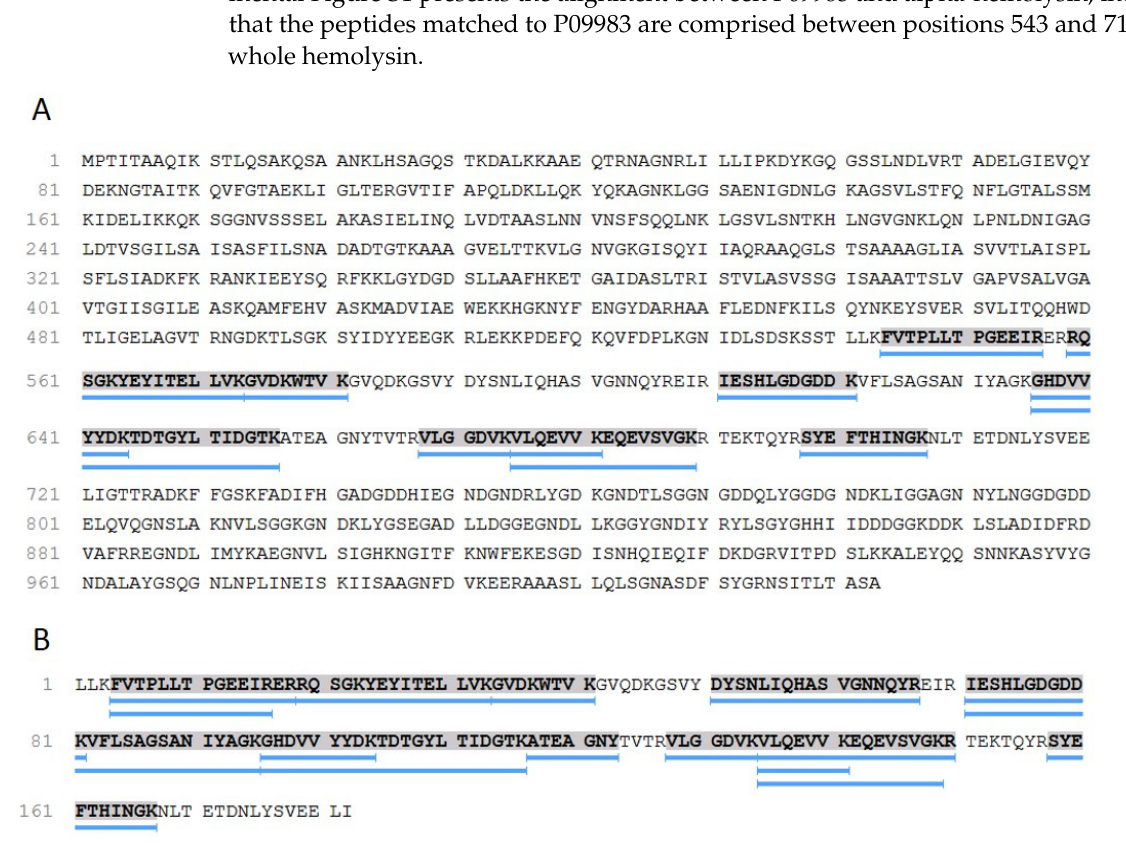
Figure 5. ( A ) Coverage map representing the proteomic identification of Hemolysin (P09983), and ( B ) recombinant HlyA, according to Peaks Studio analyses. Underlines in blue represent the proteomically-matched peptides over the deposited sequence from Escherichia coli .